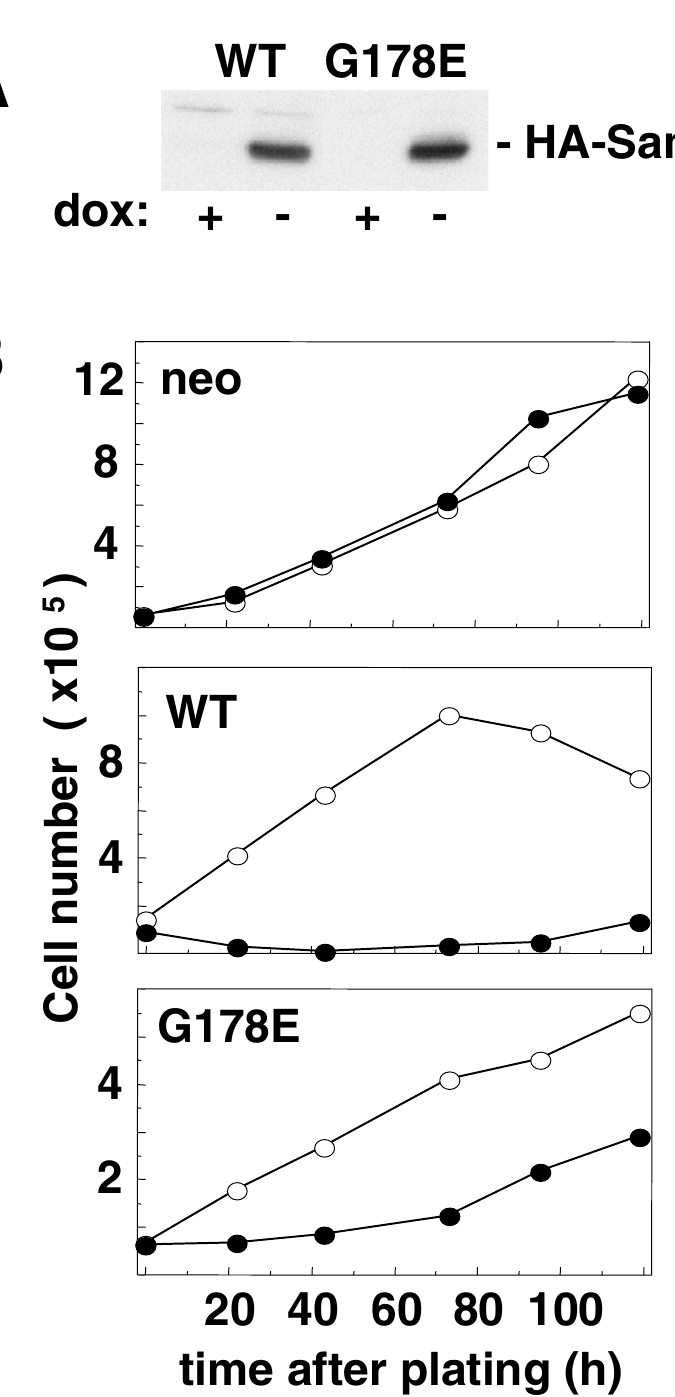
Figure 1 Sam68 overexpression inhibits cell proliferation independently of RNA binding. A. Tet -off cells conditionally expressing wild-type (WT) or RNA binding-defective (G178E) HA-epitope tagged Sam68 were grown in the presence or absence of 100 ng/ml doxycycline for 24 h. HA-Sam68 expression was assessed by immunoblotting with anti-HA antibody. B. Cells conditionally expressing wt or G178E HA-Sam68 or no cDNA (neo) were plated at low density and cultured in the pres- ence or absence of doxycycline. Adherent cells were collected by trypsinization and counted at the indicated times after plat- ing. Results are representative of three separate